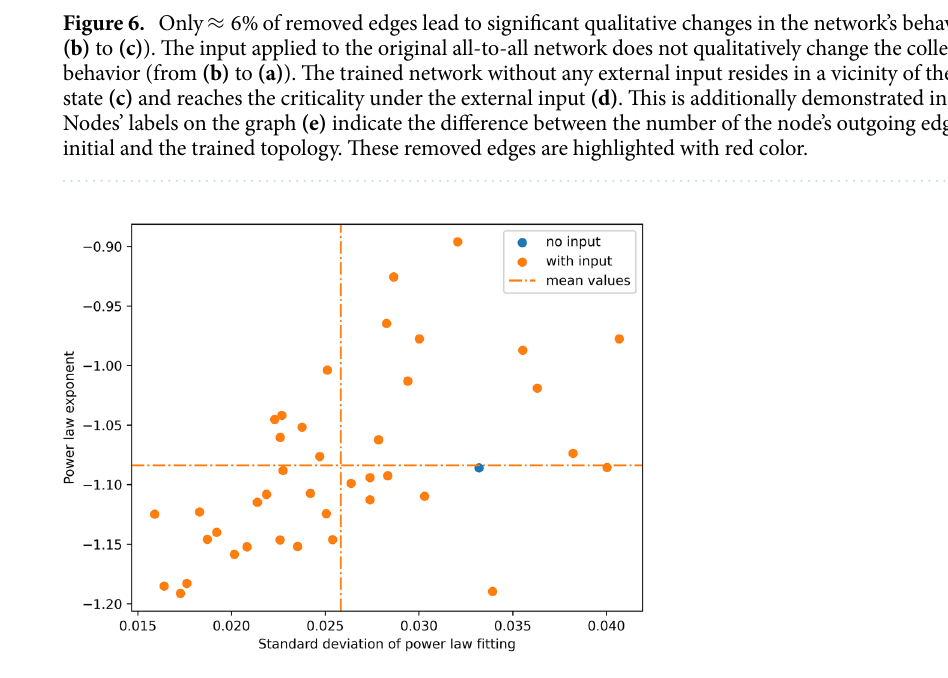
Figure 7. Power law exponent and standard deviation of the power law fitting for different inputs. External inputs do not change the mean exponent of the power law distribution, however, the standard deviation of the power law fitting decreases under the input. This indicates that the trained network without an input resides in the vicinity of the critical state and the external input brings it closer to